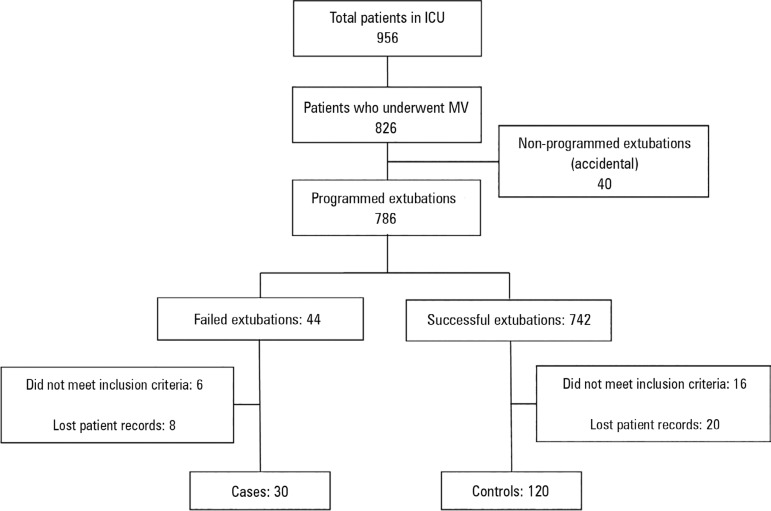
Flow chart of patients.ICU - intensive care unit; MV - mechanical ventilation.